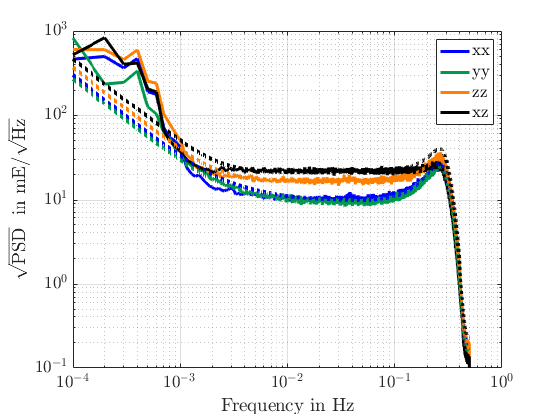
Figure 3. Solid lines: Power spectral densities (PSD) of the residuals of the SGG data from 15 December to 23 December 2012 with respect to the GO_CONS_GCF_2_TIM_R6 (TIM6 [4]) reference model. Dotted lines: Reciprocal PSDs of the filter models created for the reprocessed gradient data measured after February 2010. The colors correspond to the four used gradient components V xx , V yy , V zz , and V xz .